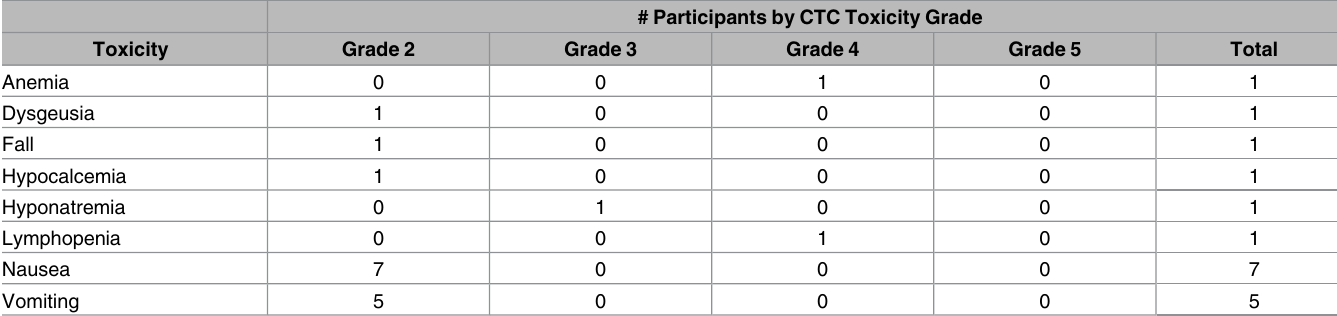
Table 2. Summary of toxicities with related or probable attribution.